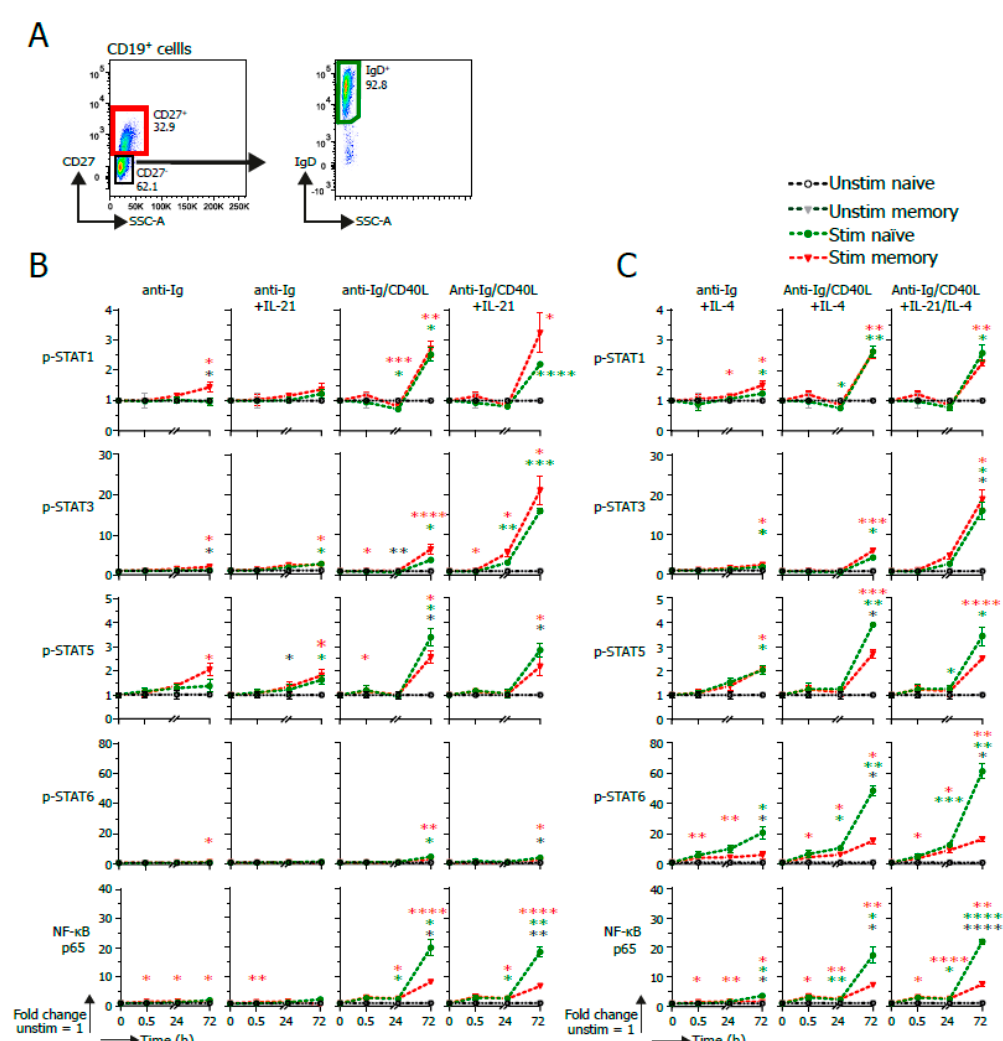
Figure 4. pSTAT and NF- κ B signaling in naïve and memory B cells upon B cell activation via BCR, CD40 or IL4 / Il-21. A total of 10,000 human naïve (CD19 + CD27 − IgD + ) or memory (CD19 + CD27 + ) B cells ( n = 3) were stimulated after sorting with an anti-Ig F(ab) 2 mix (5 µ g / mL) either together or not together with CD40L-expressing 3T3 cells and recombinant IL-4 (25 ng / mL) and / or IL-21 (50 ng / mL) cytokines. Multiple signaling proteins were analyzed by phosphoflow analysis up to 72 h of stimulation. ( A ) Representative FACS plots of the sorting strategy for purification of CD19 + CD27 + memory and CD19 + CD27 − IgD + naïve B cells. ( B ) Quantification of GeoMFI of signaling proteins in stimulated sorted naïve or memory B cells after 30 min, 24 h or 72 h stimulation with varying IL-21 stimulations. Fold change was calculated normalizing expression to unstimulated condition. p values were calculated using a mixed-e ff ect analysis with Tukey’s multiple-comparison test. * p < 0.05, ** p < 0.01, *** p < 0.001 and **** p < 0.0001. Red * shows significance of stimulated memory compared to unstimulated, green * shows significance of stimulated naïve compared to unstimulated, and black * shows significance of stimulated naïve vs. stimulated memory. ( C ) Quantification of GeoMFI of signaling proteins in stimulated sorted naïve or memory B cells after 30 min, 24 h or 72 h stimulation with varying IL-4 stimulations. Fold change was calculated normalizing the expression to the respective unstimulated condition. p values were calculated by using a mixed-e ff ect analysis with Tukey’s multiple comparison test. * p < 0.05, ** p < 0.01, *** p < 0.001and **** p < 0.0001. Red * shows significance of stimulated memory compared to unstimulated, green * shows significance of stimulated naïve compared to unstimulated, and black * shows significance of stimulated naïve vs. stimulated